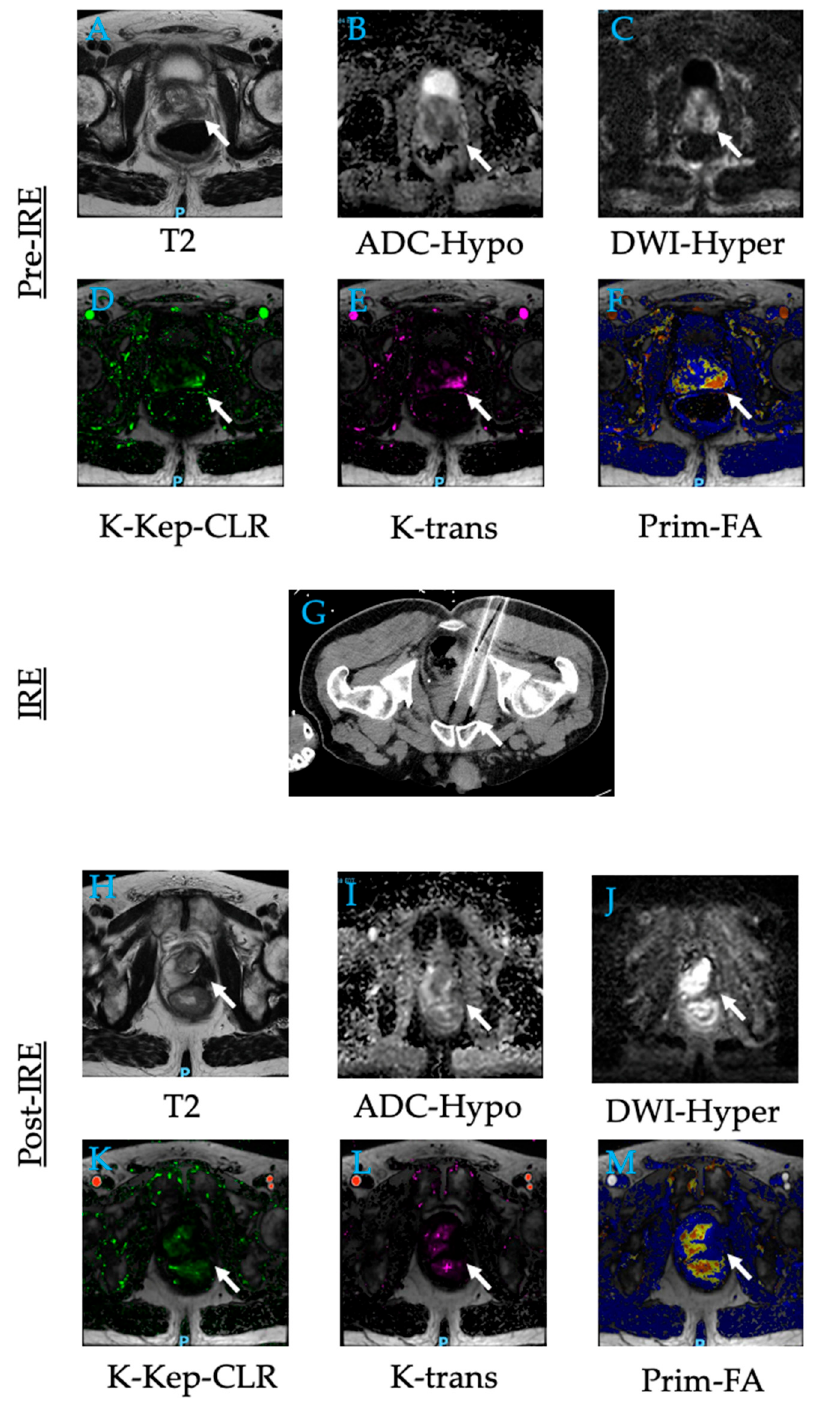
Figure 15. Irreversible electroporation of left prostate adenocarcinoma. A 64-year-old male with elevated PSA for which he underwent biopsy that showed adenocarcinoma in the left base of the prostate (white arrow) with Gleason score 7 and 8. ( A – F ) Contrast MR image of the prostate demonstrated a mass in the left peripheral zone. ( G ) He underwent IRE for the left side of his prostate. ( H – M ) Follow-up MR images show no residual tumor after 12 months. Abbreviations: ADC, apparent diffusion coefficient color-coded perfusion maps; DWI, diffusion-weighted imaging; DCE, color-coded dynamic contrast enhancement perfusion maps including K-Kep-CLR, K-trans, and